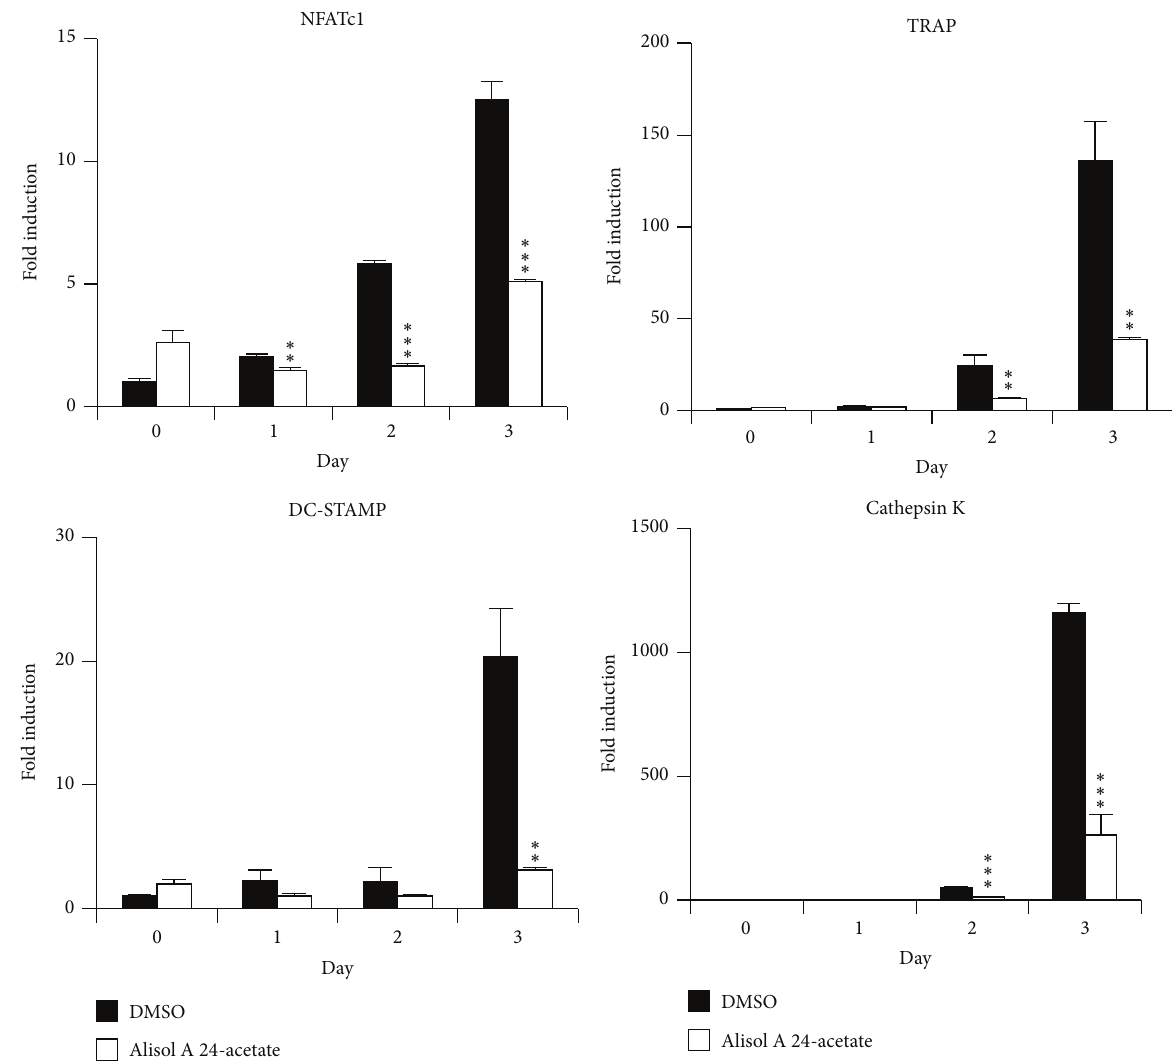
Figure 3: Alisol A 24-acetate decreased NFATc1 transcriptional expression by RANKL stimulation. BMMs were pretreated with vehicle (DMSO) or alisol A 24-acetate (10 𝜇 M) for 30 minutes and then stimulated with RANKL (10ng/mL) for the indicated number of days. Expressed mRNA levels were analyzed by real-time PCR compared with the vehicle control. ∗∗ 𝑃 < 0.01 ; ∗∗∗ 𝑃 < 0.001 ( 𝑛 = 3